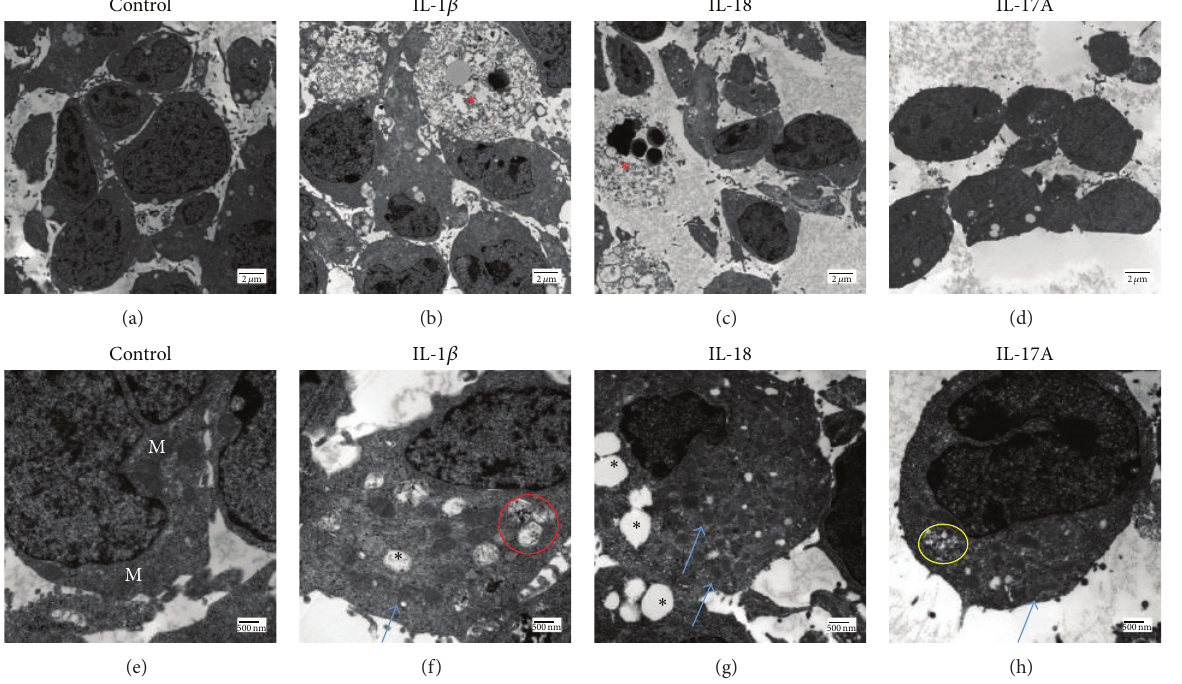
Figure4: RSCultrastructurechange after stimulation.Control((a),(e)),100ng/mLIL-1 𝛽 ((b),(f)),10ng/mLIL-18((c),(g)),and10ng/mL IL- 17A ((d), (h)) (M, mitochondria; black asterisks, cytoplasmic vacuoles; red asterisks, necroptotic cells; blue arrows, degenerated mitochondria; red circle, autophagosome; yellow circle, glycogen